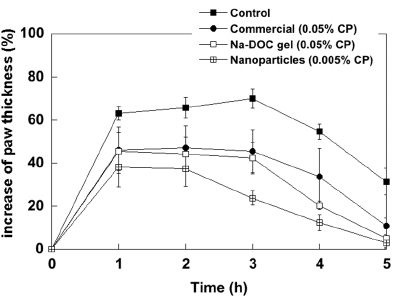
Figure 2. Increase of paw thickness (%) as a function of the time after carrageenan injection.